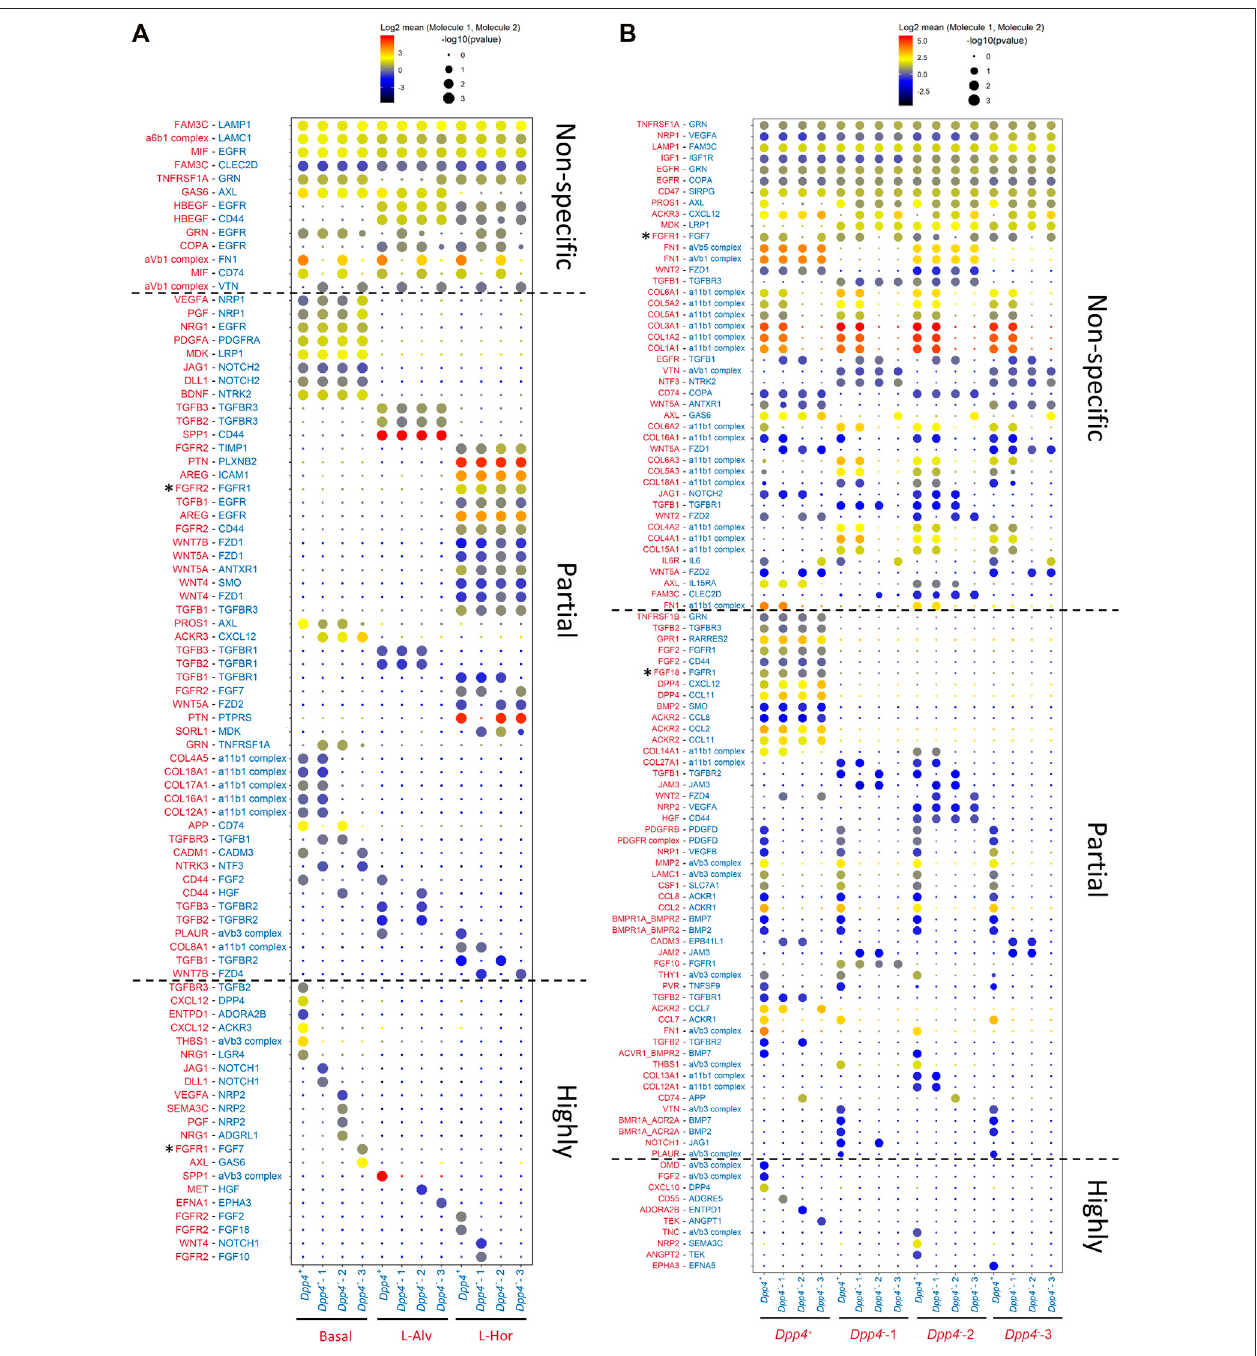
FIGURE 6 | Cell-cell interaction inference. (A,B) The signi fi cant ligand-receptor pairs between (A) mammary epithelial cells and fi broblasts and (B) fi broblasts and fi broblasts.Sizeandcolorofeachdotrepresentthe p valueandtheleveloflog2meanexpressionoftheidenti fi edligand-receptorpairineachrowbetweenthecelltypes ineachcolumn,respectively.Thecolorofthemoleculesinrowismatchedwiththecelltypeexpressingthemoleculesindicatedincolumn.Theasterisks(*)representthe FGFR/FGF-related interaction pairs whichwereidenti fi edbythe cell-cellinteractioninference but wereconsidered tobebiologicallyimprobableinteractionsbased on the previous publications (Bellot et al., 1991; Ornitz et al., 1996; Zhang et al., 2006).